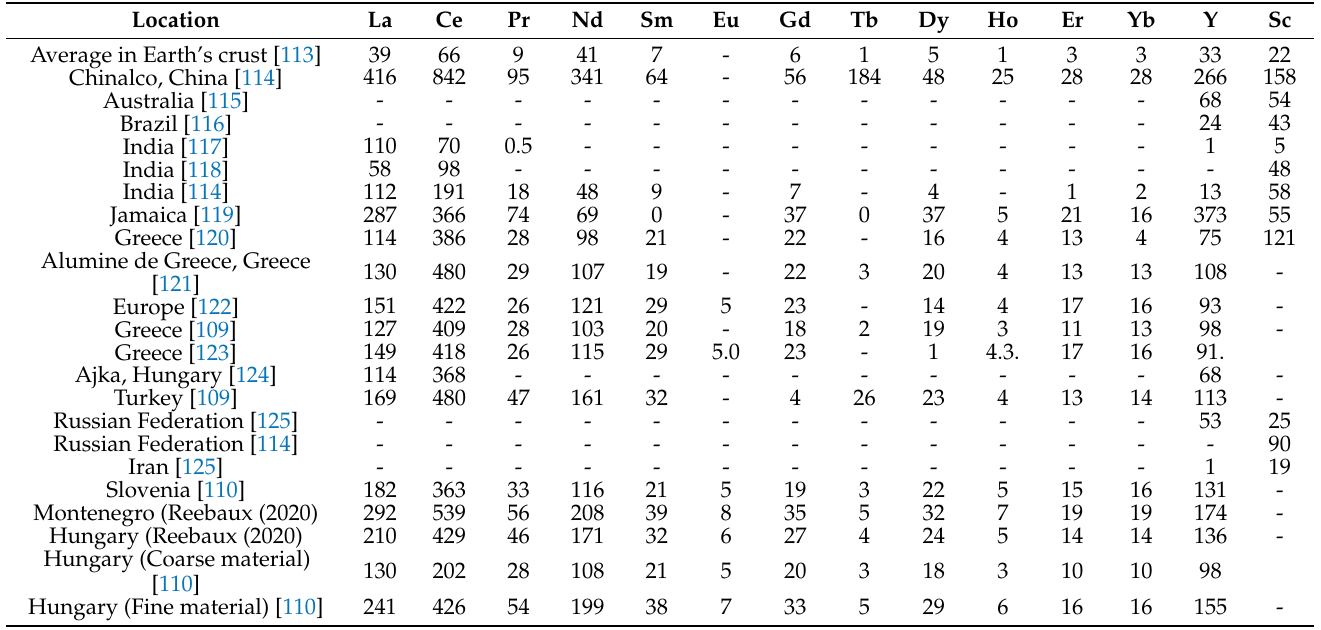
Table 5. REE, Y, and Sc concentrations ( µ g/g) of red mud from different countries in comparison with the Earth’s average crust composition, modified from